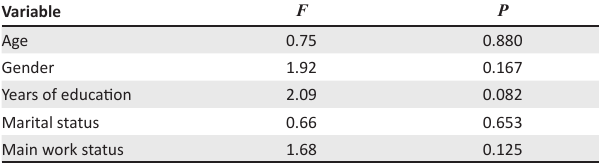
TABLE 2: Association between demographics factors and participation. Variable